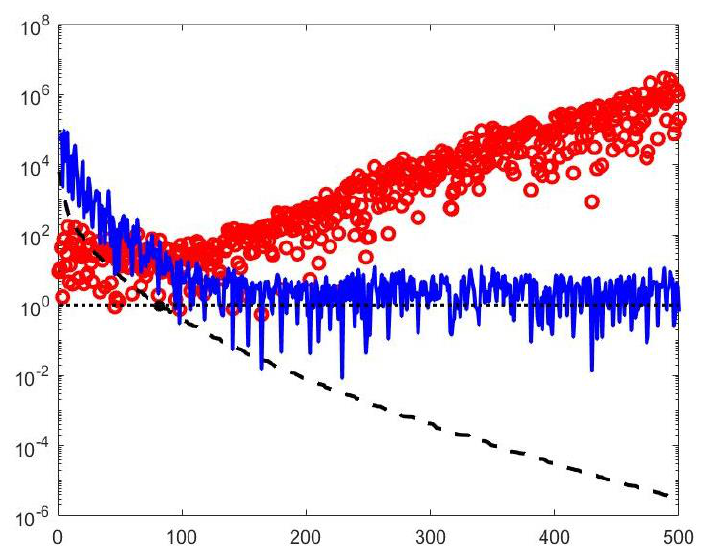
Figure 5. The Picard plot for the simulated NMR data. Singular values σ i (black dashed line), Fourier s (blue continuous line) and solution coefficients u T coefficients u T i